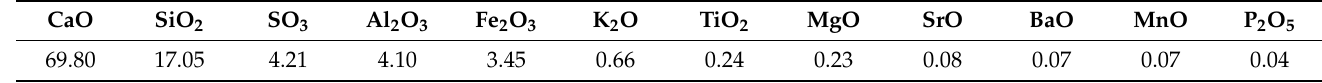
Table 1. Percentage chemical composition of cement type CEM II/B ‐ L ‐ 32.5 N.